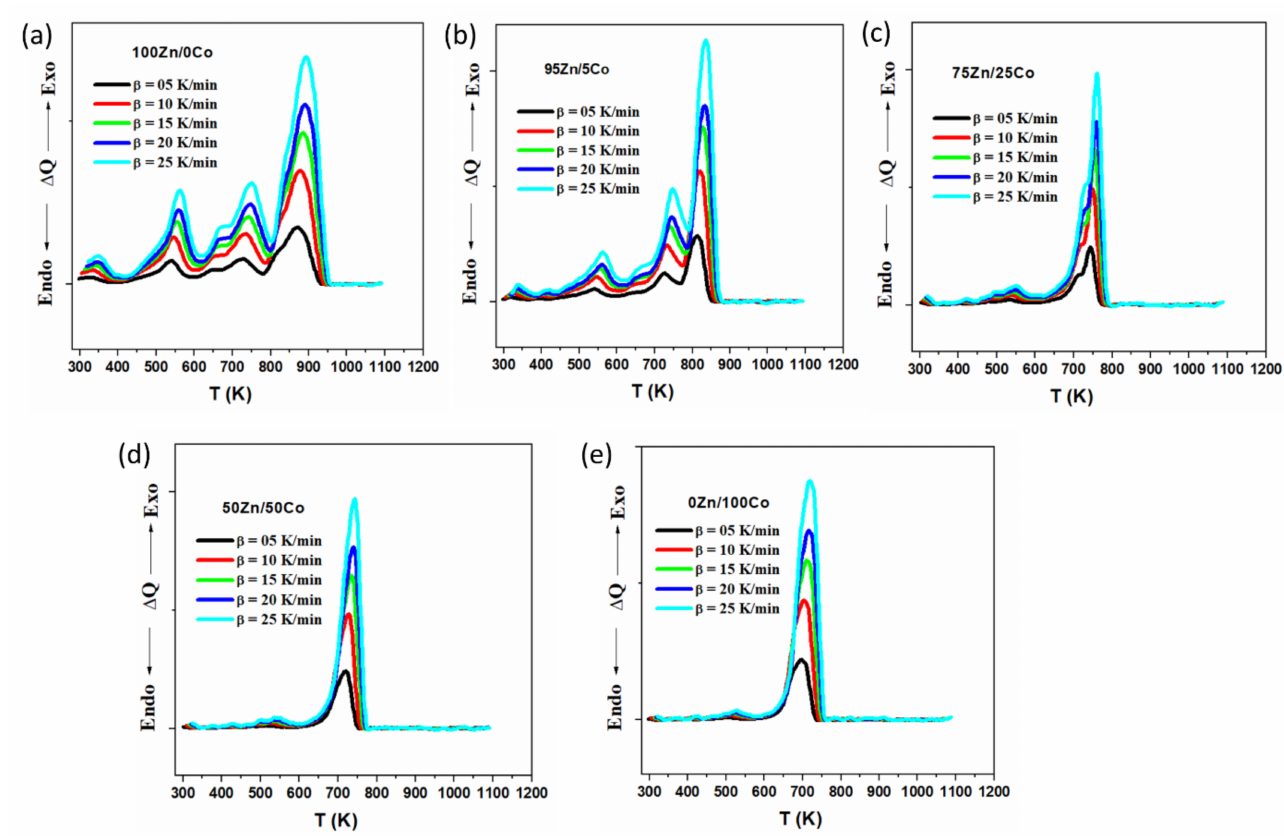
Figure 9. ( a – e ): The DSC of Zn x Co 1-x -ZIF-8 for a different